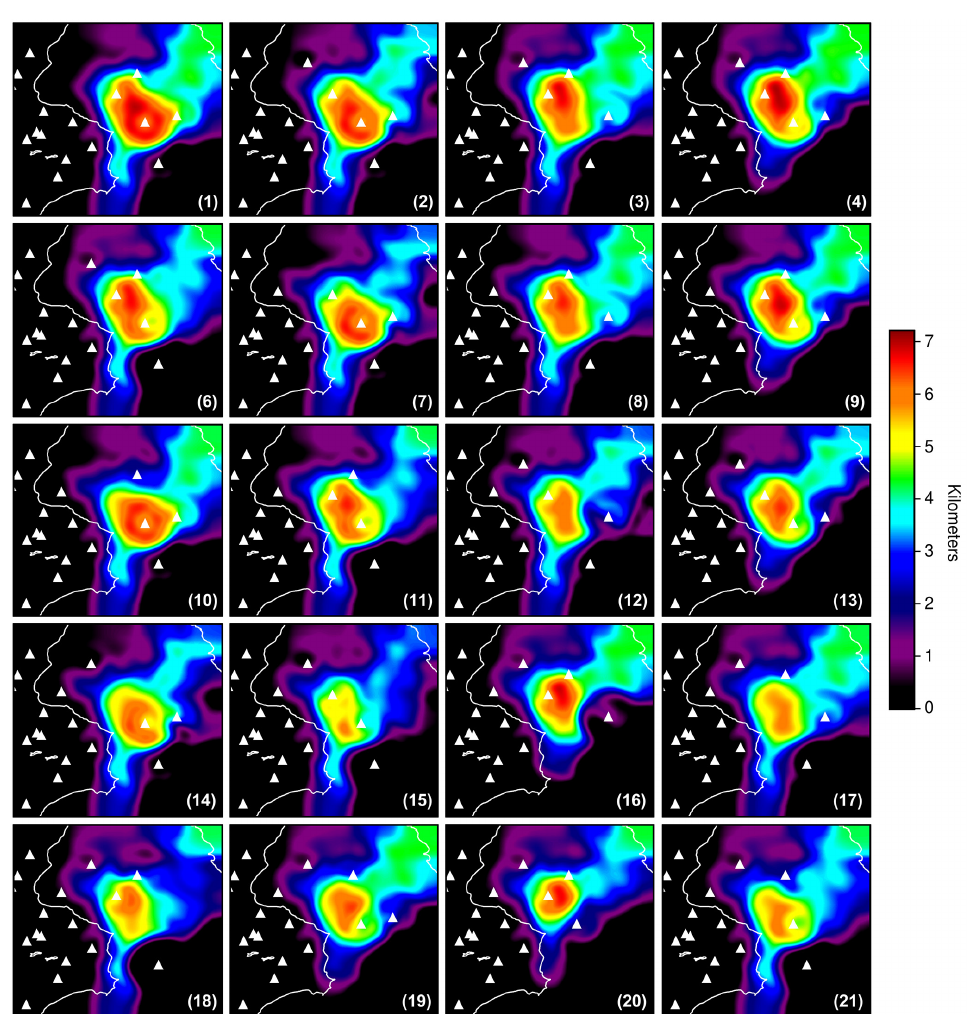
Figure 4. Improvement maps for the area of interest as average RES over all the investigated hypocenter depths, for different stations geometry; white triangles indicates the stations position; geometry 5 is showed in Fig.